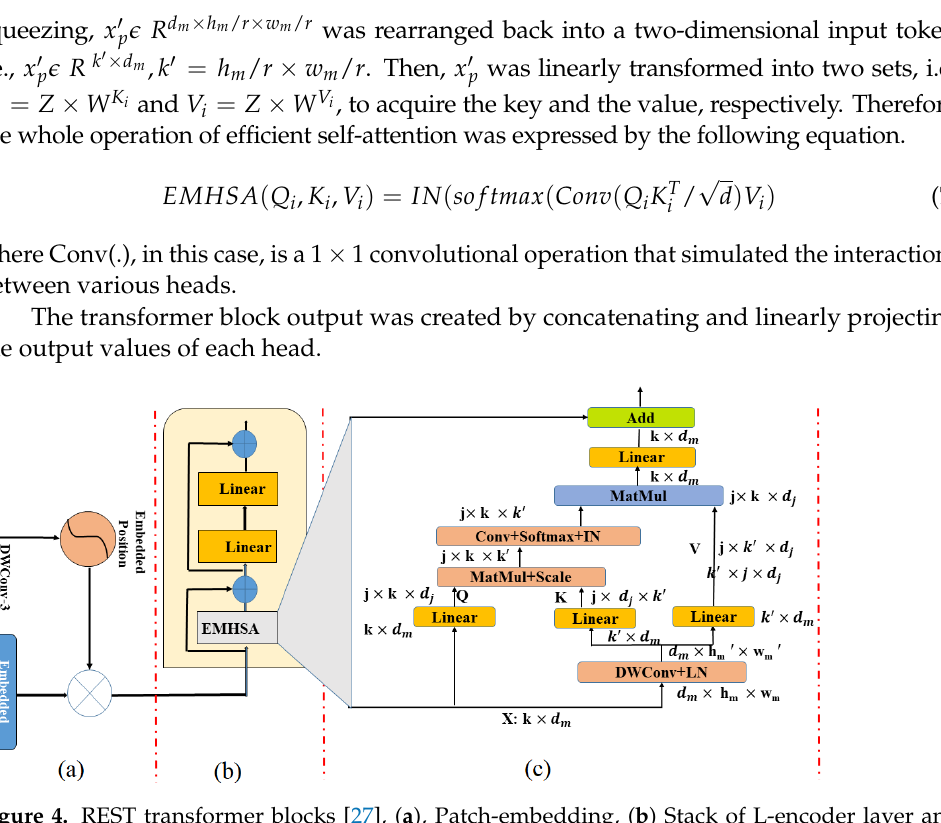
Figure 4. REST transformer blocks [27], ( a ), Patch-embedding, ( b ) Stack of L-encoder layer and ( c ) Efficient